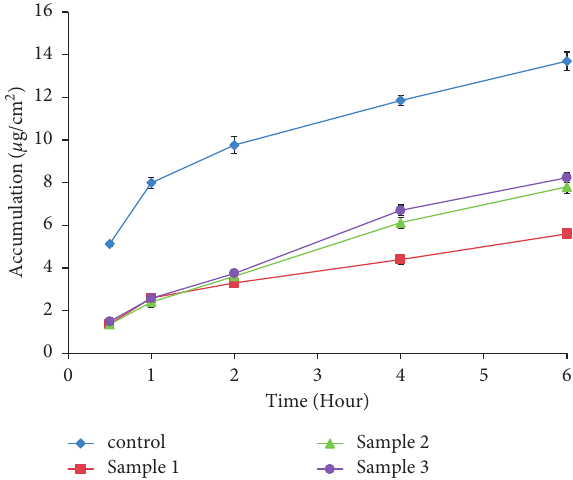
Figure 4: In vitro release profiles of butyl methoxydibenzoylmethane microcapsules.